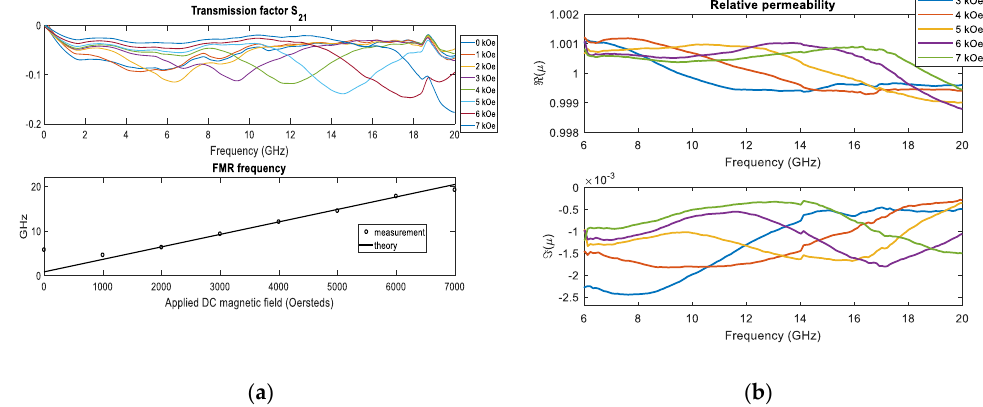
Figure 12. ( a ) Dependence of FMR phenomenon on applied DC magnetic field ranging from 0 kOe to 7 kOe, for magnetic Fe 3 O 4 @GO nanoparticles ( b ) real (top) and imaginary (bottom) part of permeability µ r